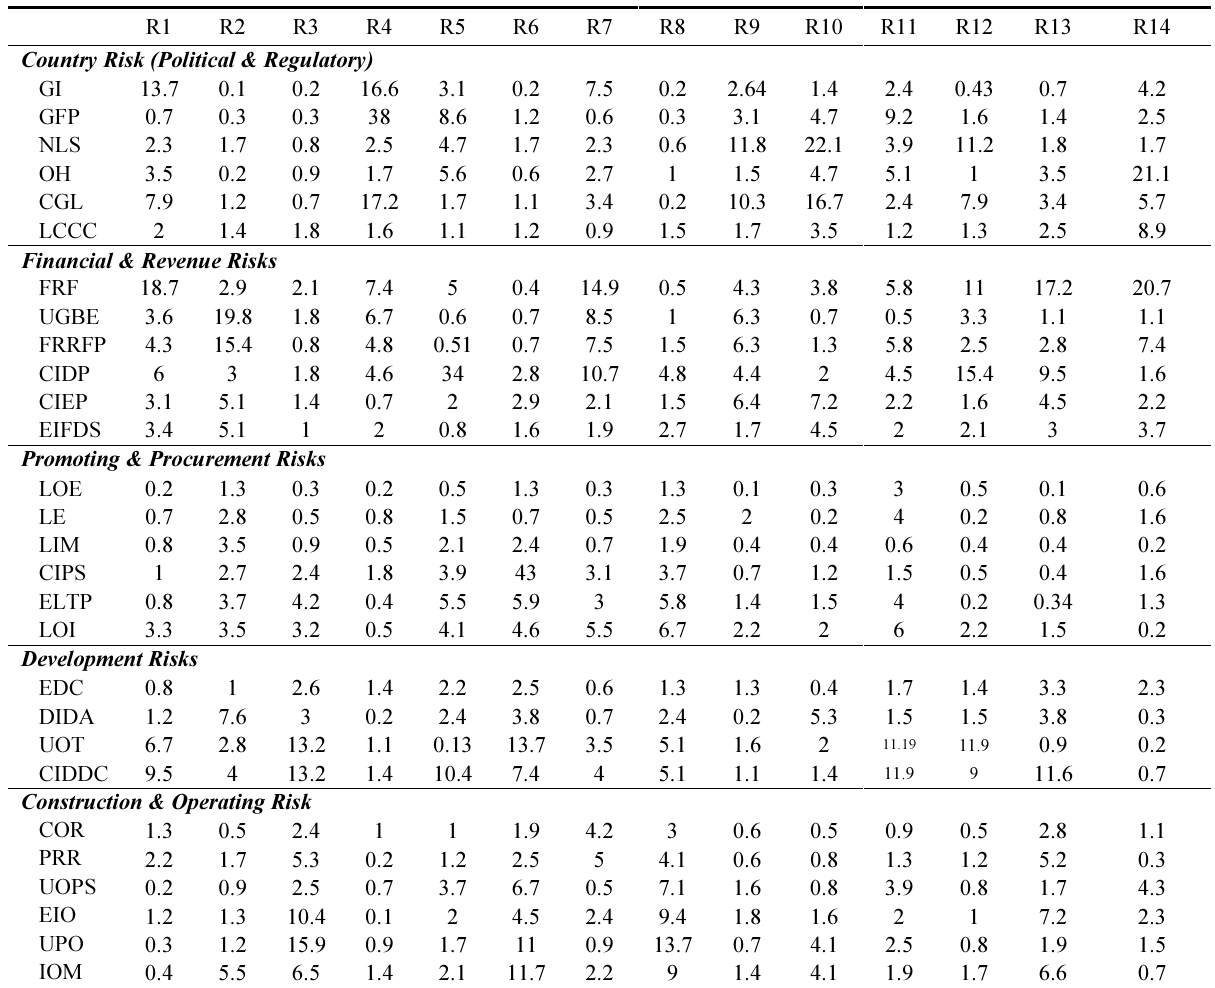
Table 5. Local composite weights of the attribute towards the project risk (×10E-2) R1 R2 R3 Country Risk (Political & Regulatory) GI GFP 0.7